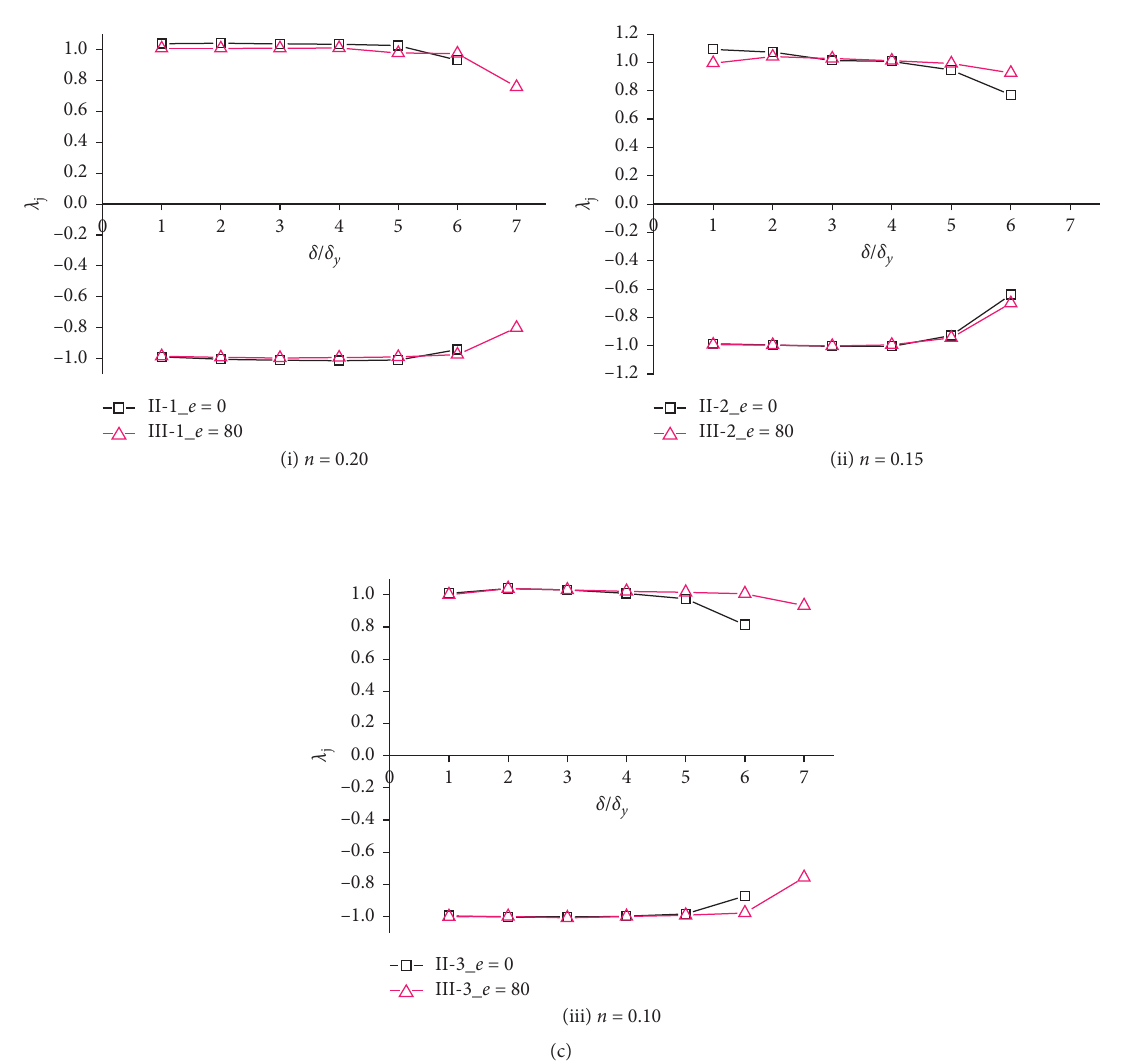
Figure 11: Degradation characteristic of strength. (a) Effects of installing buckling-restrained energy dissipation wall plates. (b) Effects of axial compression ratio n . (c) Effects of eccentricity e .